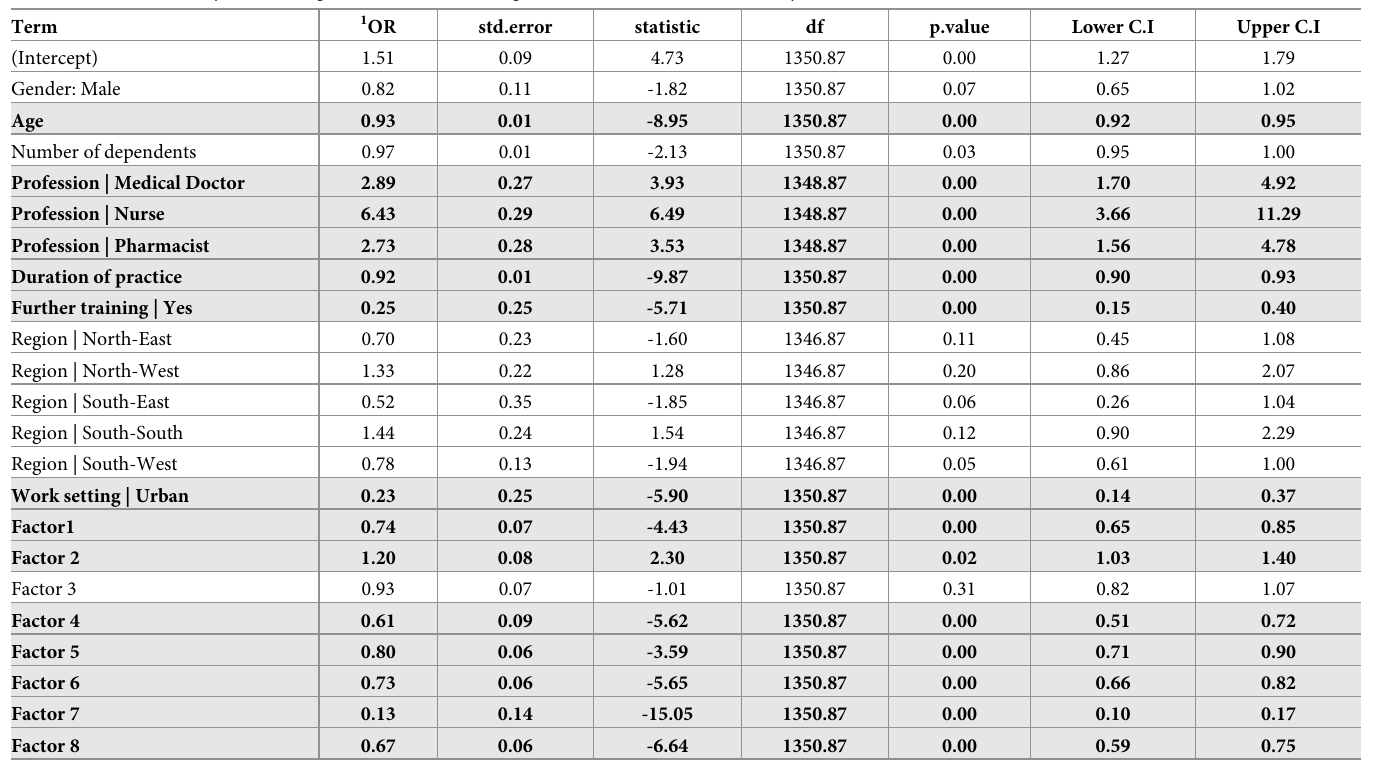
Table 2. Univariate analysis involving SHWs who wish to migrate versus those who wish to